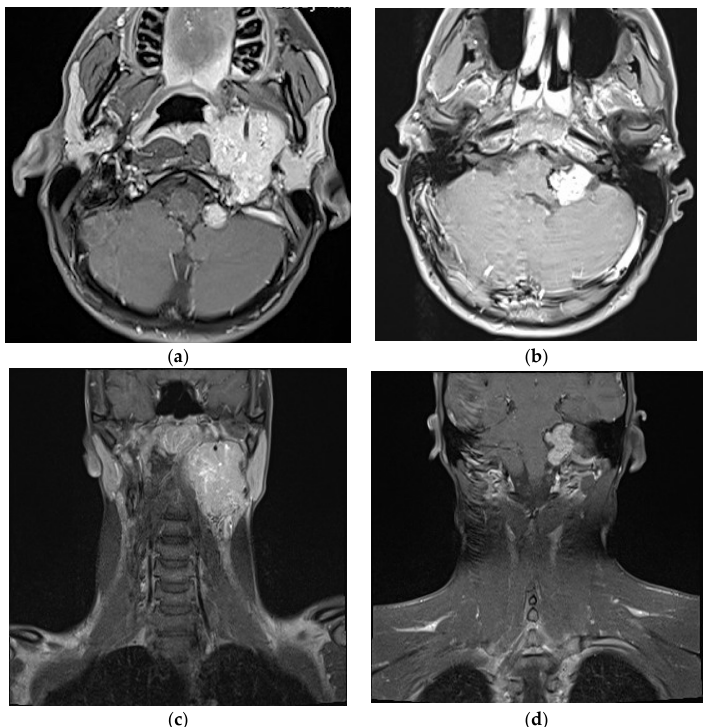
Figure 1. ( a – d ) T1 contrast enhanced transversal MRI demonstrating the tumor growing from the jugular foramen into the posterior cavity and the upper neck.